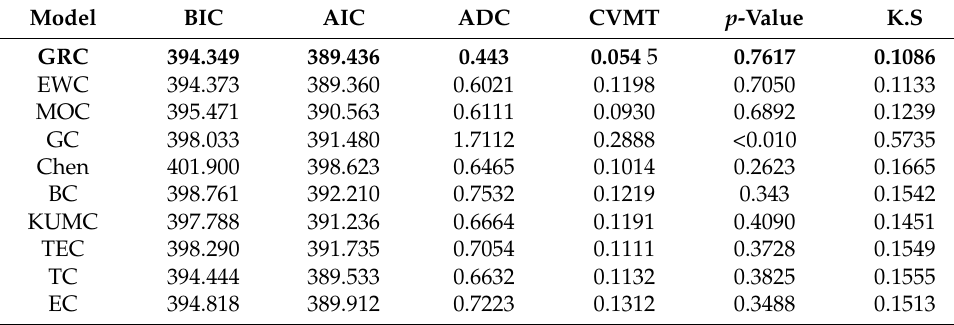
Table 3. Comparing models under the flow data